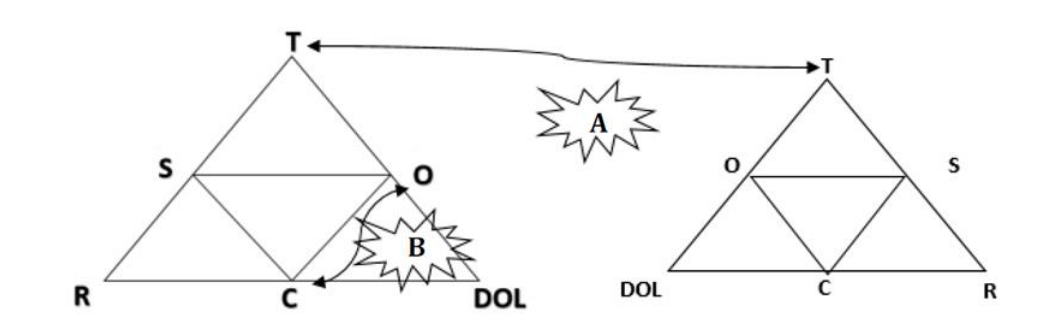
Figure 9: double binds